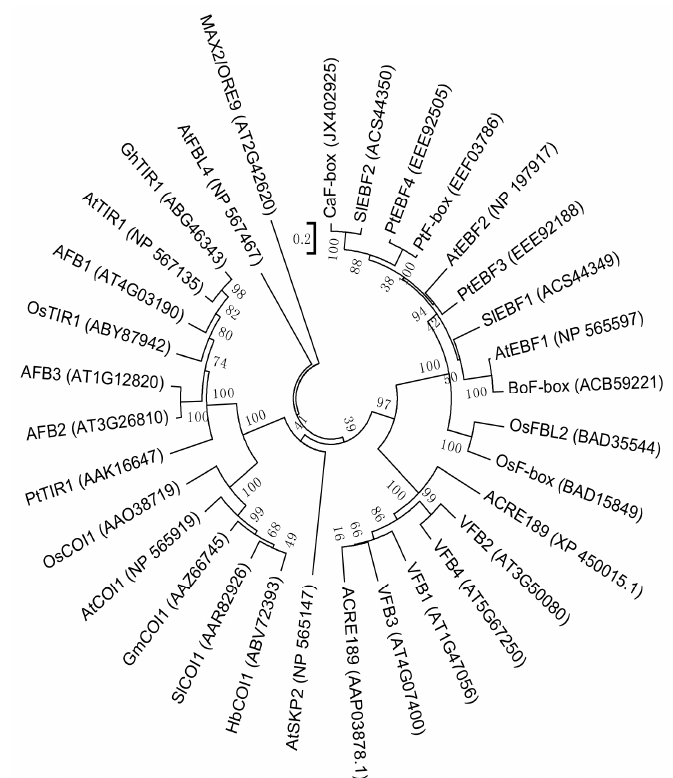
Figure 2. Phylogenetic tree of CaF-box and homologous F-box proteins from other species. The rooted gene tree (majority-rule consensus from 1000 bootstrap replicates) was constructed using the heuristic searching option in Mega5.1. Bootstrap values are indicated at each branch node. GenBank accession numbers are in parentheses after each species and gene name. The scale bar shows the similarity